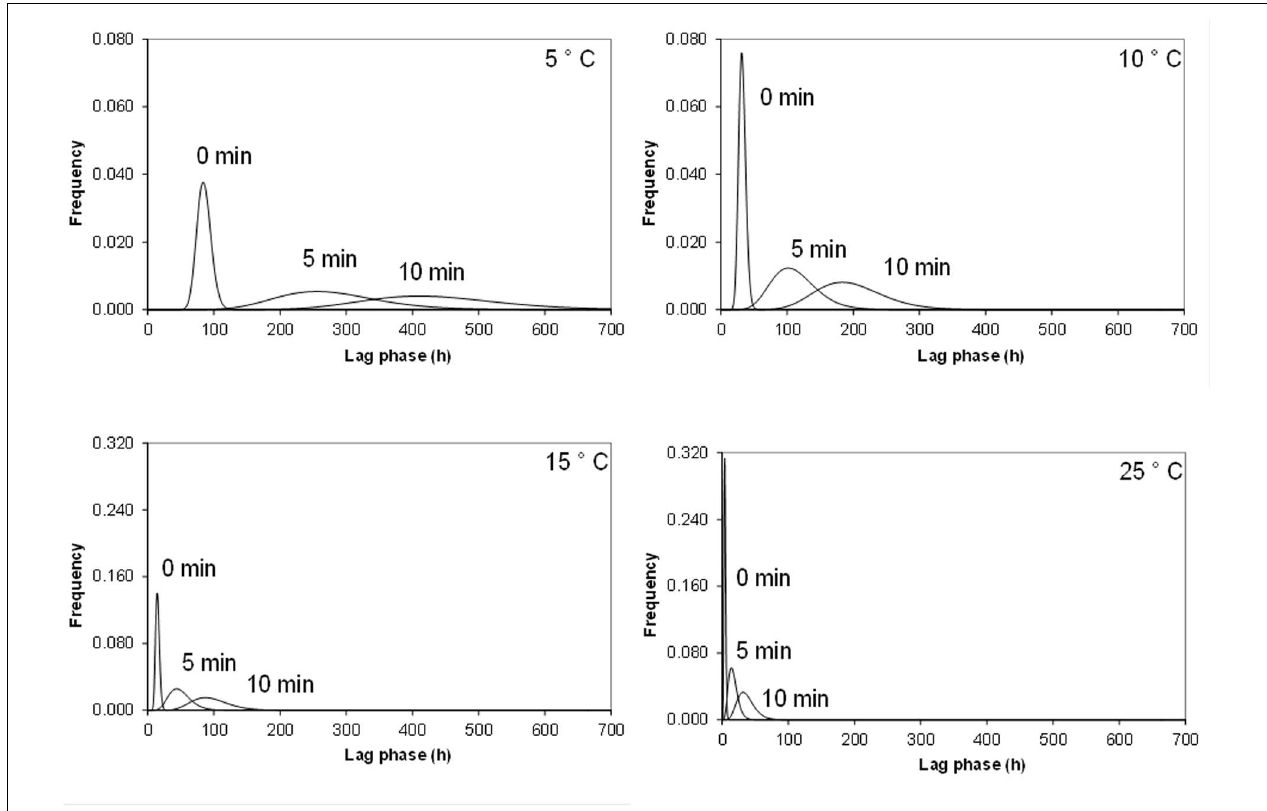
FIGURE 1 | Frequency distribution of individual Cronobacter sakazakii lag phases fitted by gamma distribution at different growth temperatures after 50 ◦ C heat shock by 0, 5, and 10